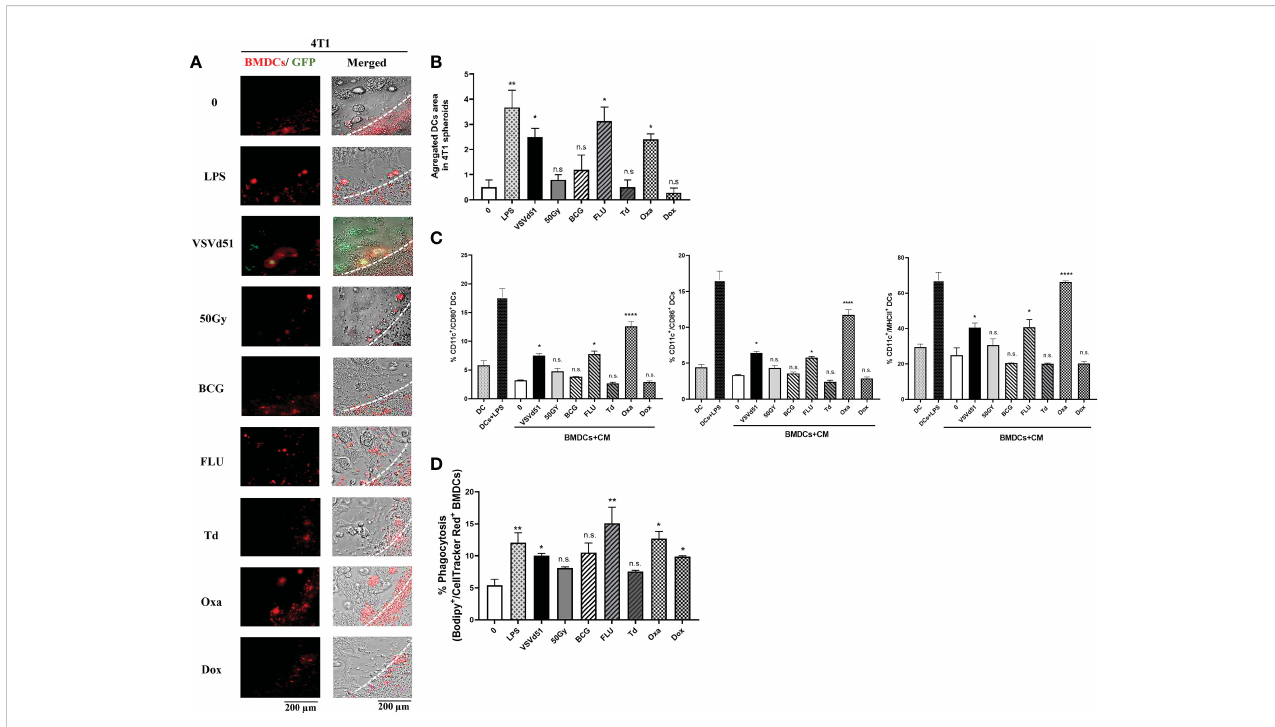
FIGURE 3 Enhanced recruitment and activation of mouse dendritic cells following exposure to TNBC spheroids treated with oxaliplatin or in fl uenza vaccine. Live cell images from (A) 4T1 spheroids co-cultured with deep red CellTracker-labelled BMDCs, 24h following their treatment with ICD inducers at IC50 concentrations. LPS (1 m g/ml) treated spheroids were used as positive controls. (B) Quanti fi cation of microscopy images representing the number of in fi ltrated and aggregated immune cells around treated spheroids. Dashed lines delineate the edge of spheroids. The results are compared to non- treated cells. (C) Flow cytometry analysis of maturation markers of BMDCs following 48h of exposure to CM of 4T1 cells treated with indicated ICD inducer at IC50 concentration or 10 MOI of VSVd51. LPS treated (1 m g/ml) BMDCs were used as a positive control. (D) Flow cytometry analysis of phagocytic BMDCs labelled with deep red CellTracker and co-cultured with Bodipy TMR labelled 4T1 cells. All data are representative of at least three similar experiments where n=3 for technical replicates, *P < 0.05; **P < 0.01; ****P < 0.0001; (n.s., no signi fi